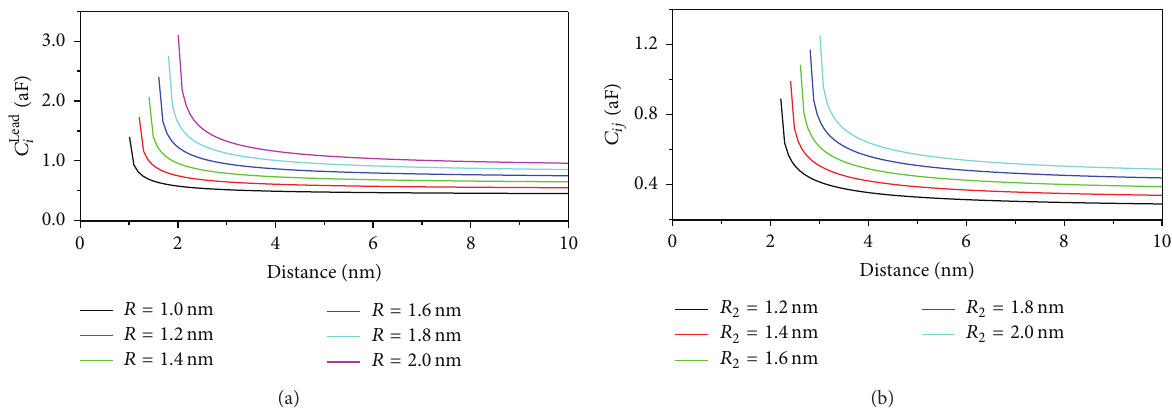
Figure 3: (a) Electrode-Qd capacity ( 𝐶 Lead 𝑖 ) for different Qds radii as a function of the distance. (b) Qd-Qd capacity ( 𝐶 𝑖𝑗 ) for different 𝑅 2 radii; the radius of one Qd is hold at 𝑅 1 = 1 nm. In both plots we use 𝜀 𝑟 = 3.9𝜀 0 , where 𝜀 0 is the vacuum permittivity.